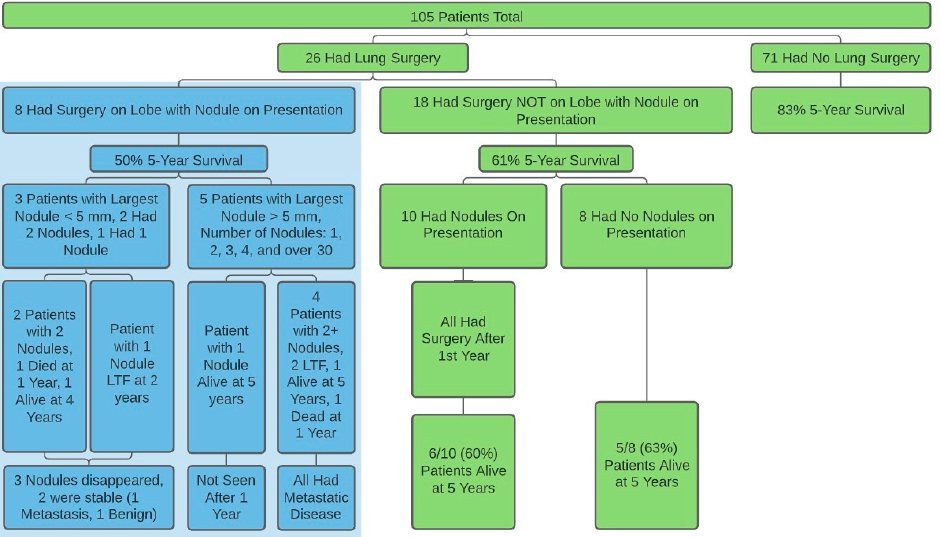
Figure 1. The number of patients who had surgery and the overall survival for each group. Patients represented in the blue box were excluded from the study because they all had surgery on the lobe with nodule involvement on presentation. LTF = Lost to follow up.